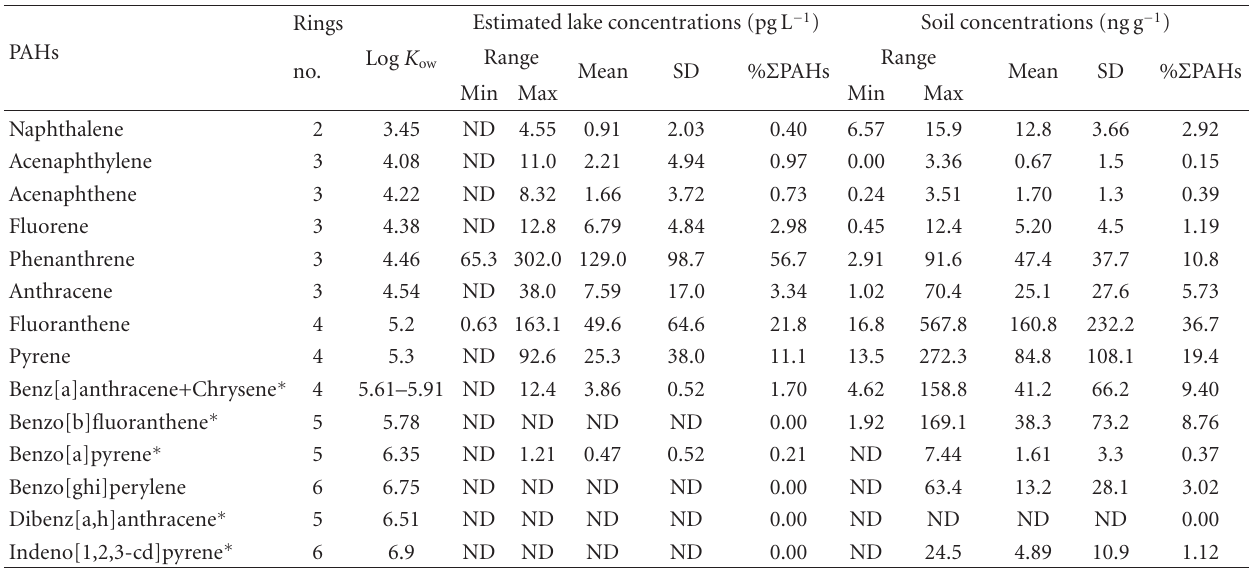
Table 2: Estimated lake water and measured soil concentrations (0–5cm) of 15 PAHs for upland study catchment ( n = 5): Lough Cummeenoughter (CUM), Lough Adanacleveen (ADA), Mullincrick Lough (MUL), Sgilloge Lough (SGI), and Cleevaun Lough